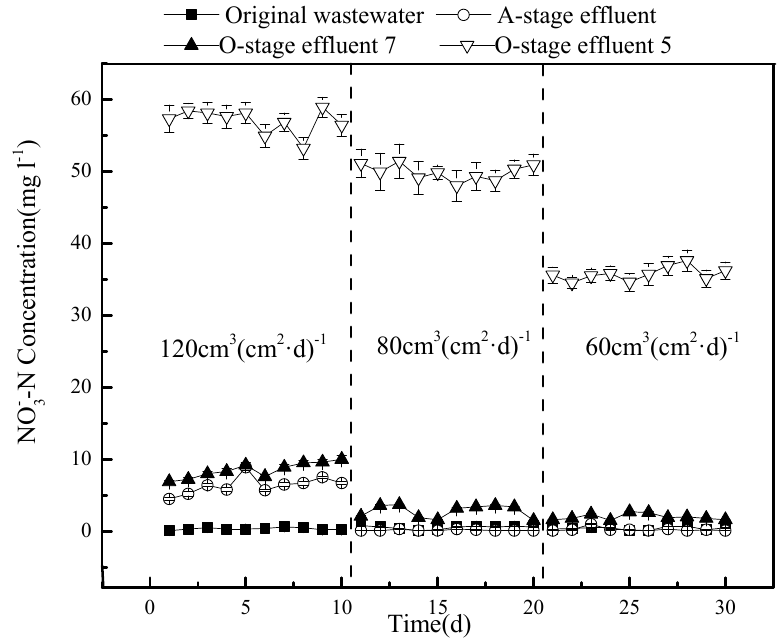
Figure 9. Variation in nitrate concentration under the three different hydraulic loads.